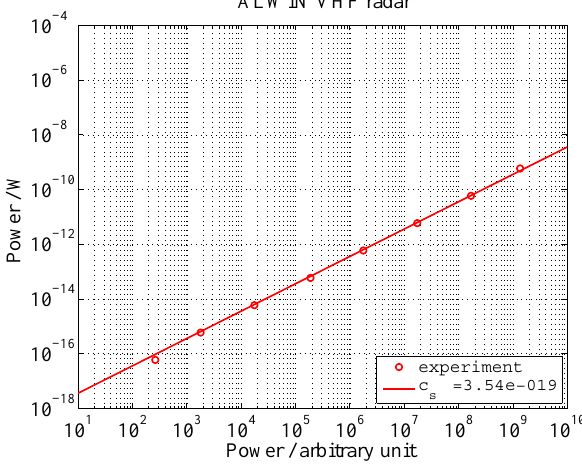
Fig. 5. Calibration with an ultra-sonic delay line: signal power in physical units (Watt) vs. signal power in arbitrary units (au) for co- herent received